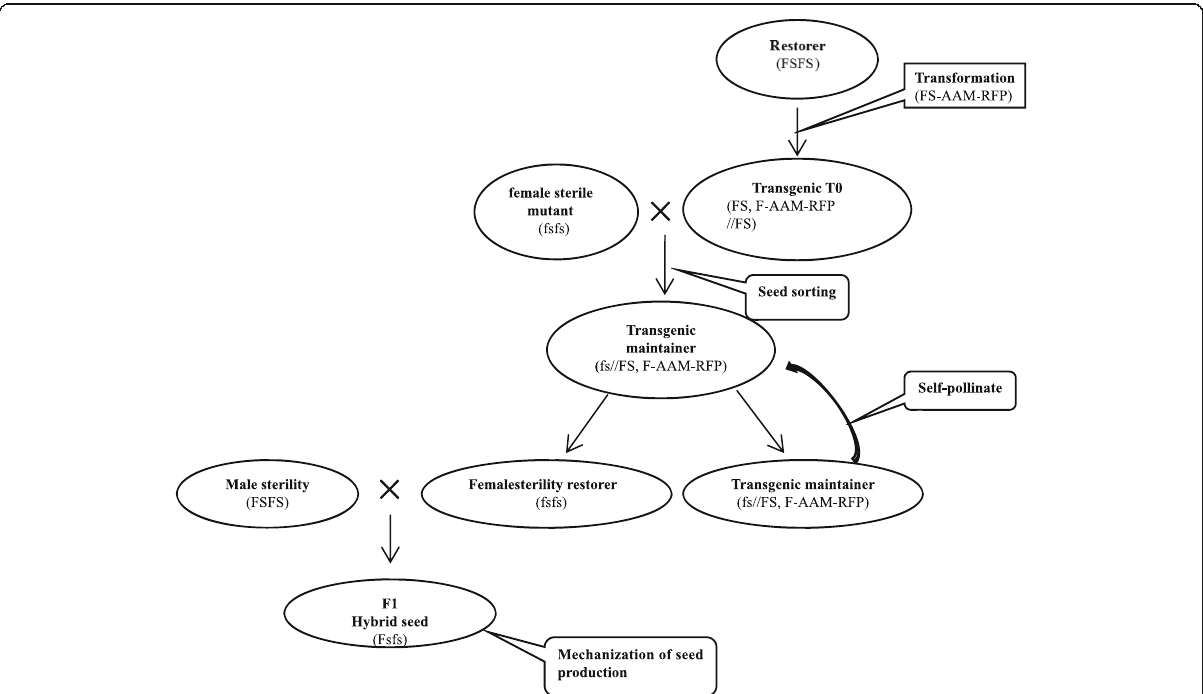
Fig. 7 Model of a nuclear female sterility system for mechanization of hybrid seed production in rice. The restorer line was created by transformation of wild-type commercial line MH86 with a vector construct containing three transgene expression cassettes: (i) the WT fertility gene (FS) to restore the female fertility, (ii) the α -amylase gene (AAM) to devitalize transgenic pollens, and (iii) the red fluorescence protein (RFP) gene to distinguish the transgenic seeds from the non-transgenic seeds. A hemizygous transgene in the female sterile mutant plant can fully restore the female fertility since the female fertility gene is a recessive sporophytic gene. The α -amylase gene, driven by a pollen-specific promoter, disrupts starch accumulation only in the transgenic pollen so only the transgenic pollen grains produced by the hemizygous transgenic plant are defective, while the non-transgenic pollen grains are viable for pollination. The resulting transgenic maintainer plant (FS, FS- AAM-RFP//fs) produces male gametes (MG) of one genotype (fs) and female gametes (FG) of two genotypes (fs and FS, FS-AAM-RFP). Self- pollination of the transgenic maintainer line generates the transgenic seed (FS, FS-AA-RFP//fs) and female sterile seed (fs//fs) in a 1:1 ratio, and the seeds can be sorted based on red fluorescence. The female sterile seeds can be propagated via self-pollination. The female sterile plants (paternal line) can be pollinated with male sterile plants (maternal line) for mechanized production of hybrid seeds. The restorer was transformed with vector